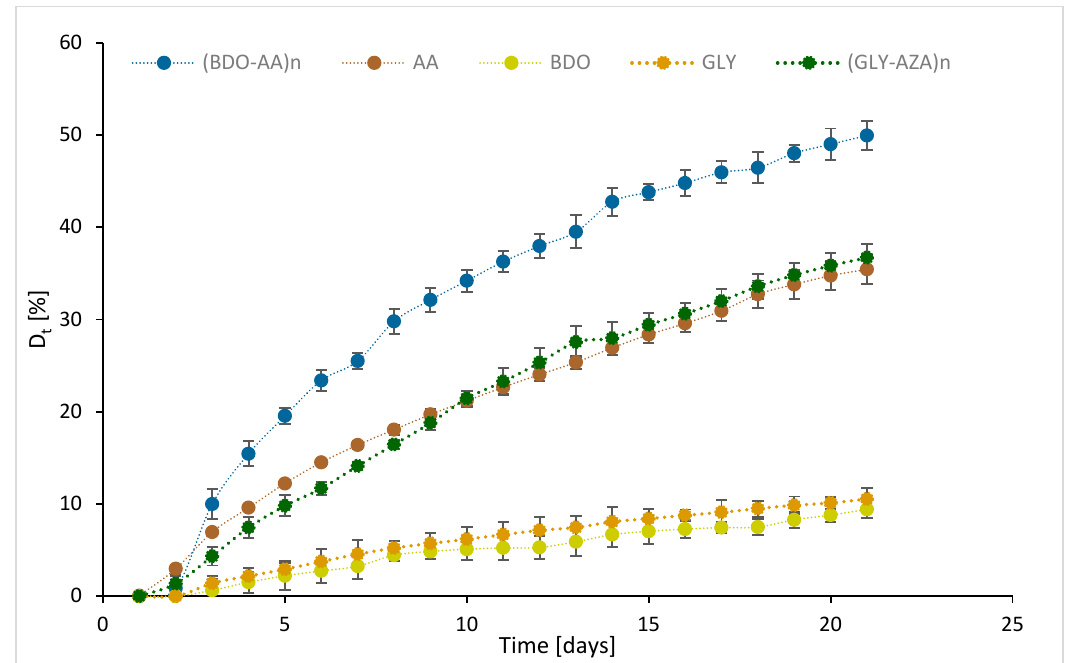
Figure 6. Degree of degradation of the oligoesters after 21 days of incubation in a marine environment; the data were normalized by subtracting the values of the control samples.